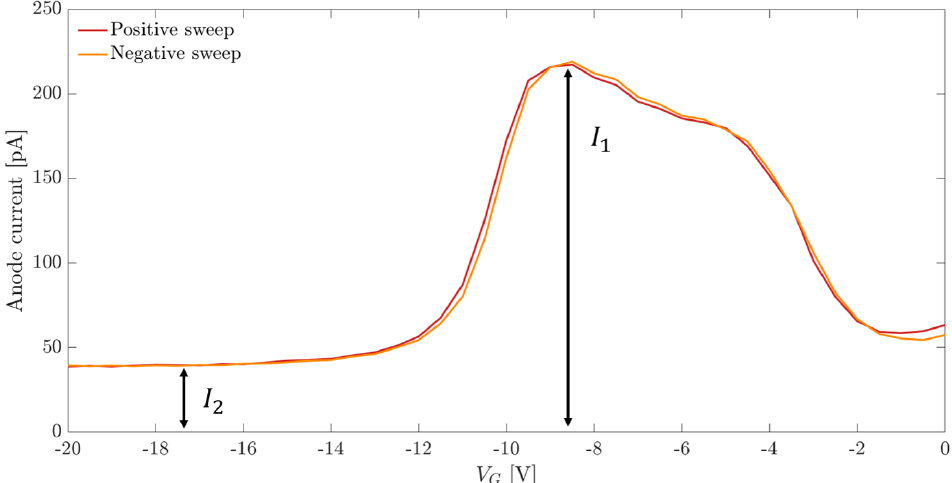
Figure 8. Gated diode anode current as a function of the applied gate voltage.